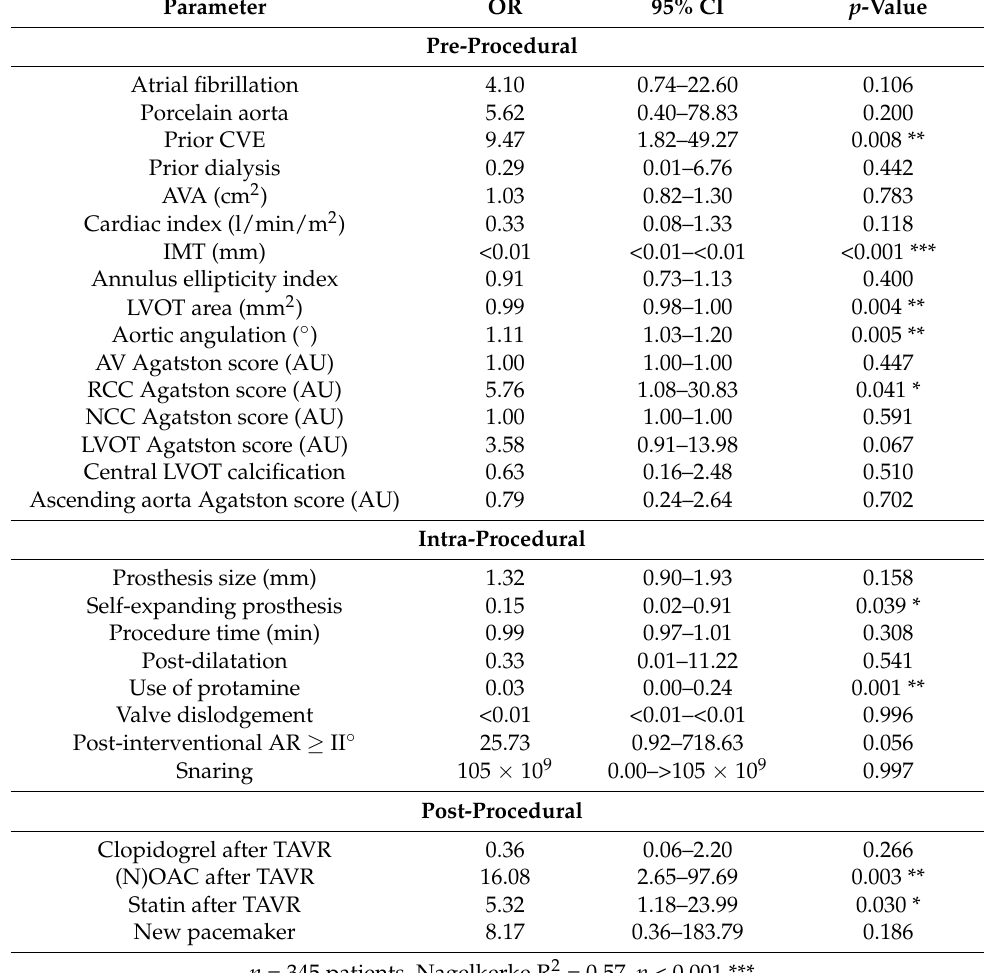
Table 2. Multivariate logistic regression for pre-procedural, intra-procedural, and post-procedural parameters. Parameter OR 95% CI p -Value Pre-Procedural Atrial